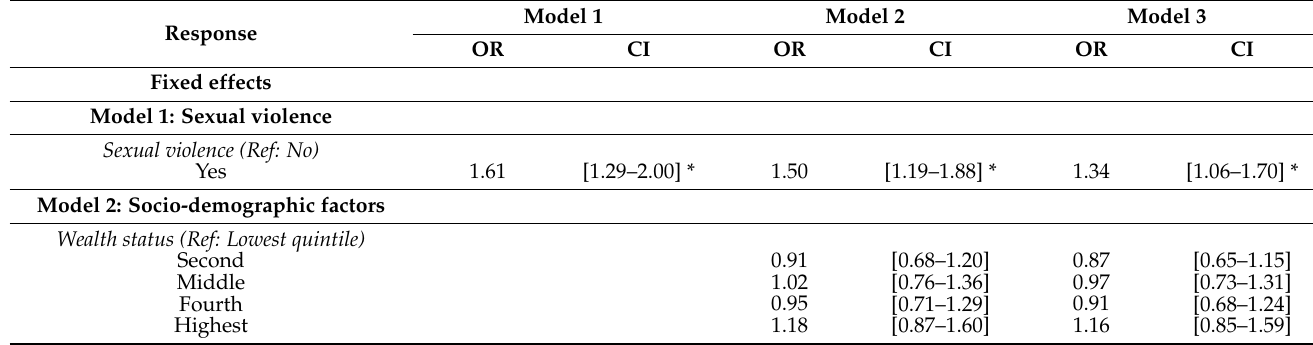
Table 3. HIV prevalence by sexual violence, UAIS, 2011 ( n =